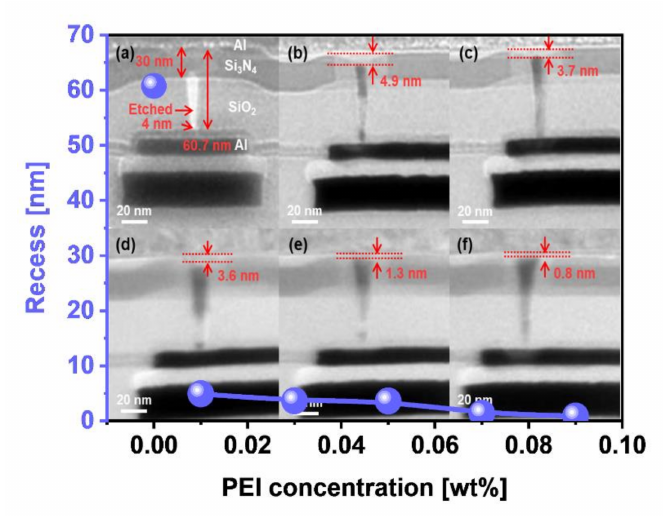
Figure 9. Dependency of polishing-induced recess on corrosion inhibitor (i.e., PEI) concentration. The background TEM images observed the presence of polishing-induced recess on the Ge 1 Sb 4 Te 5 film surface after CMP. PEI concentrations of ( a ) 0, ( b ) 0.01, ( c ) 0.03, ( d ) 0.05, ( e ) 0.07, and ( f ) 0.09